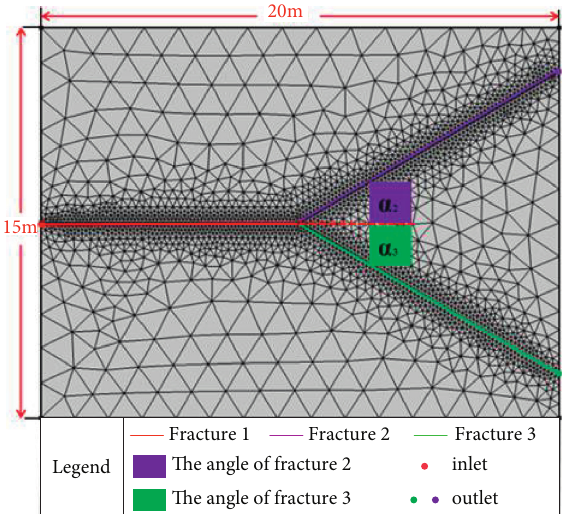
Figure 6: The numerical model and grid division of water-displacing diffusion of slurry in fractures.